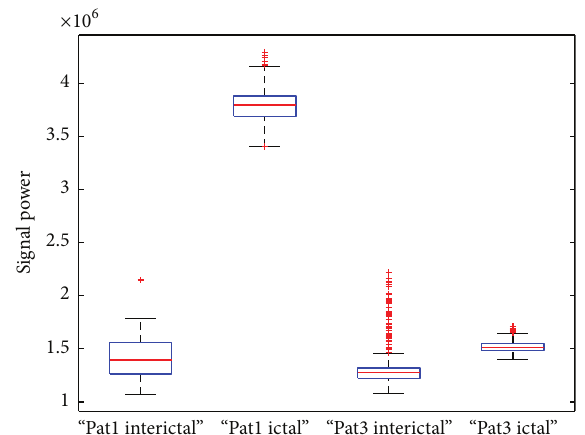
Figure 5: Box plots of average power of signal segments for patients 1 and 3. One hour long signal is used and 𝑙 = 1280 is